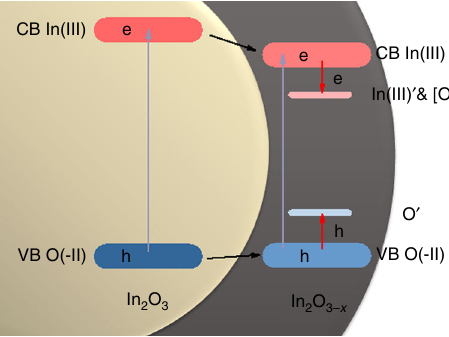
Fig. 5 Illustration of the electronic band structure. The In 2 O 3 − x /In 2 O 3 heterostructure showing the In(III) ′ , [O] electron-trapping and O ′ hole- trapping mid-gap energy states near the CB and VB edges, respectively. Included also in the diagram is the outcome of photoexcitation and relaxation of electrons and holes involving valence, conduction and mid-gap